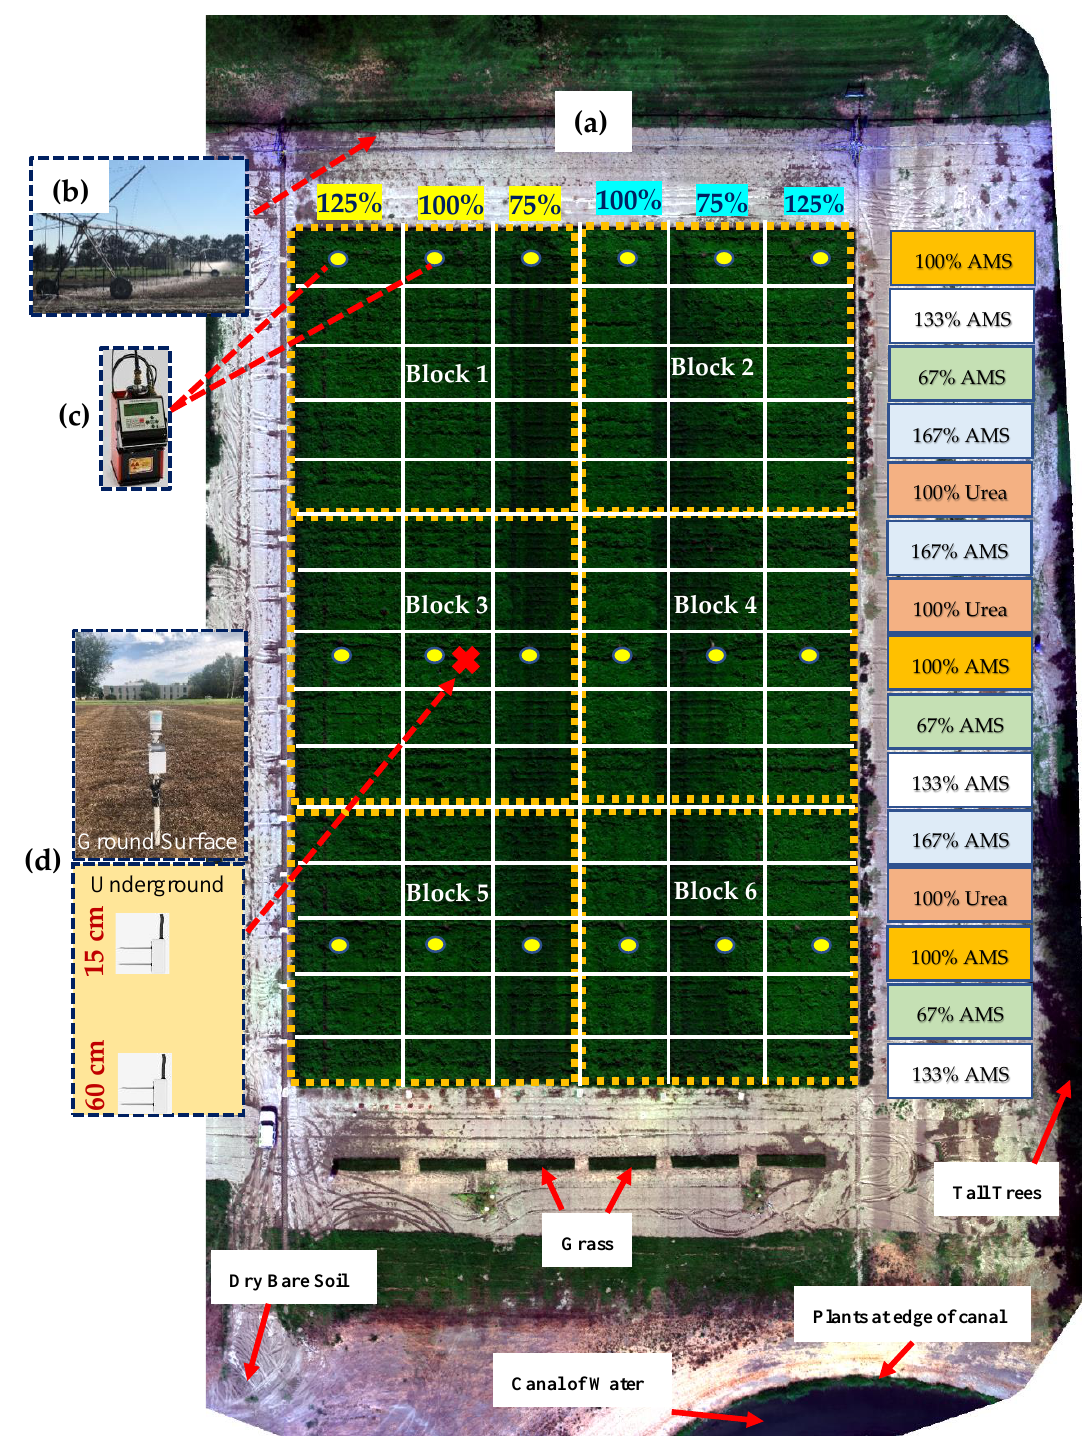
Figure 1. ( a ) True color image of the experimental field. ( b ) linear move irrigation system with LESA sprinkler configuration. ( c ) Locations of installed neutron probe access tubes, ( d ) Location of installed Teros 10 at two depths of 15 cm and 60 cm and ATMOS-41 which both were connected to the ZL6 data logger.